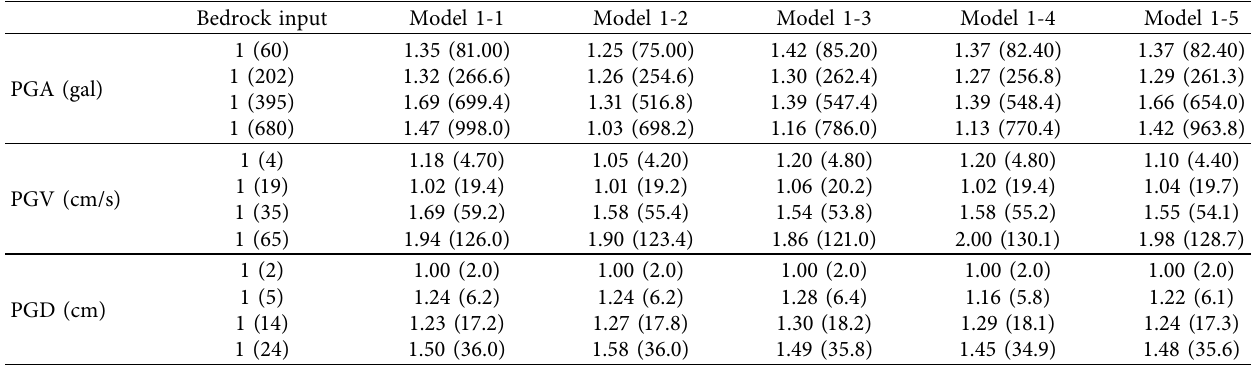
Table 3: Ground motion amplification ratios for the five single interbedded models under four seismic inputs. Bedrock